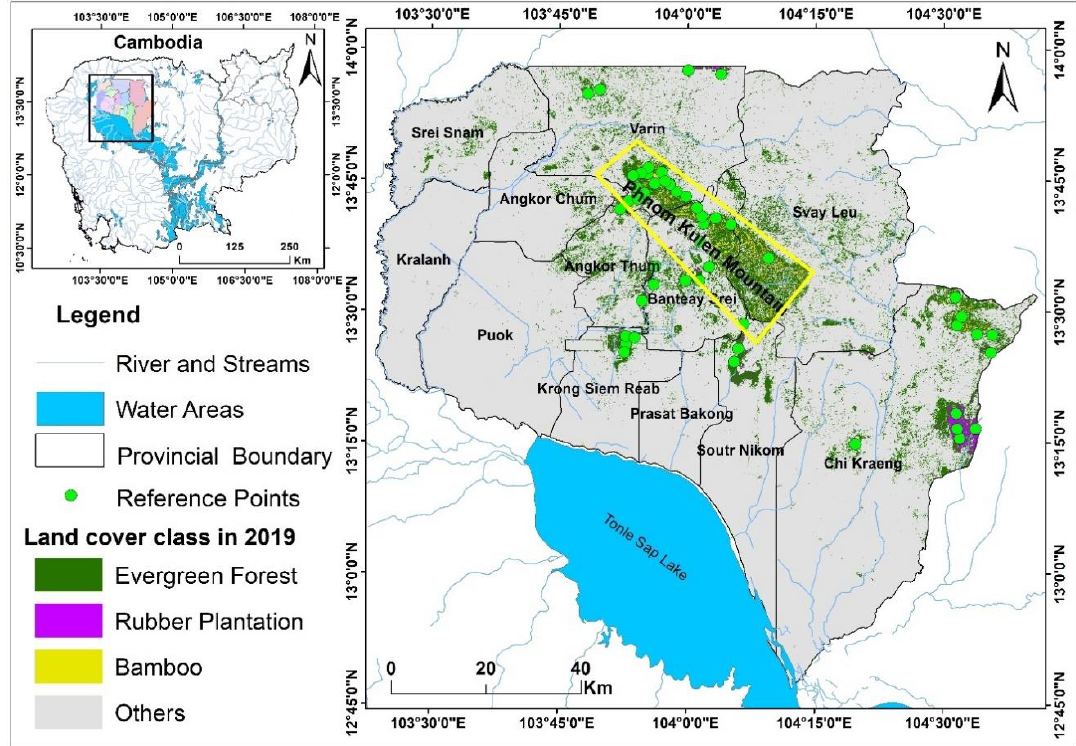
Figure 1. Map of the study area. Note: Light green points indicate phenology sampling points for bamboo, evergreen, and rubber plantations. The yellow box indicates the National Park of Phnom Kulen mountain. Source: The background map is the bamboo distribution derived from Sentinel-2 imagery in 2019 in this study. The provincial and district boundaries were obtained from Open Development Cambodia [44].